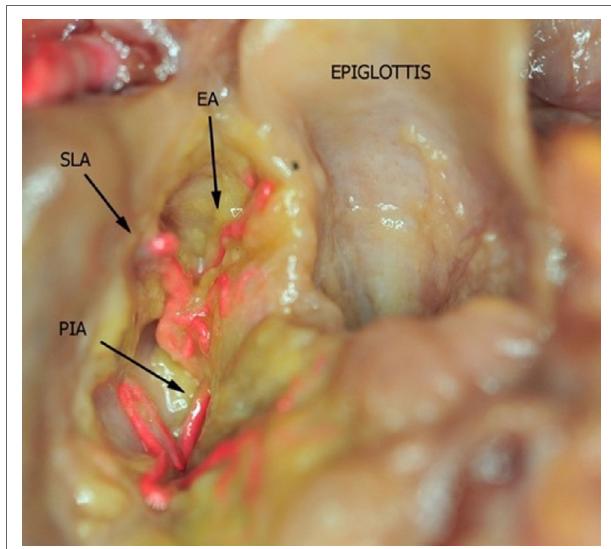
Figure 4 | Fresh-frozen cadaver larynx seen from above after partial removal of the fat tissue within the upper and lower paraglottic space. Bicomponent red silicone had been injected in the left common carotid and subclavian arteries. Abbreviations: SLA, superior laryngeal artery; EA, epiglottic artery; PIA, postero-inferior artery.